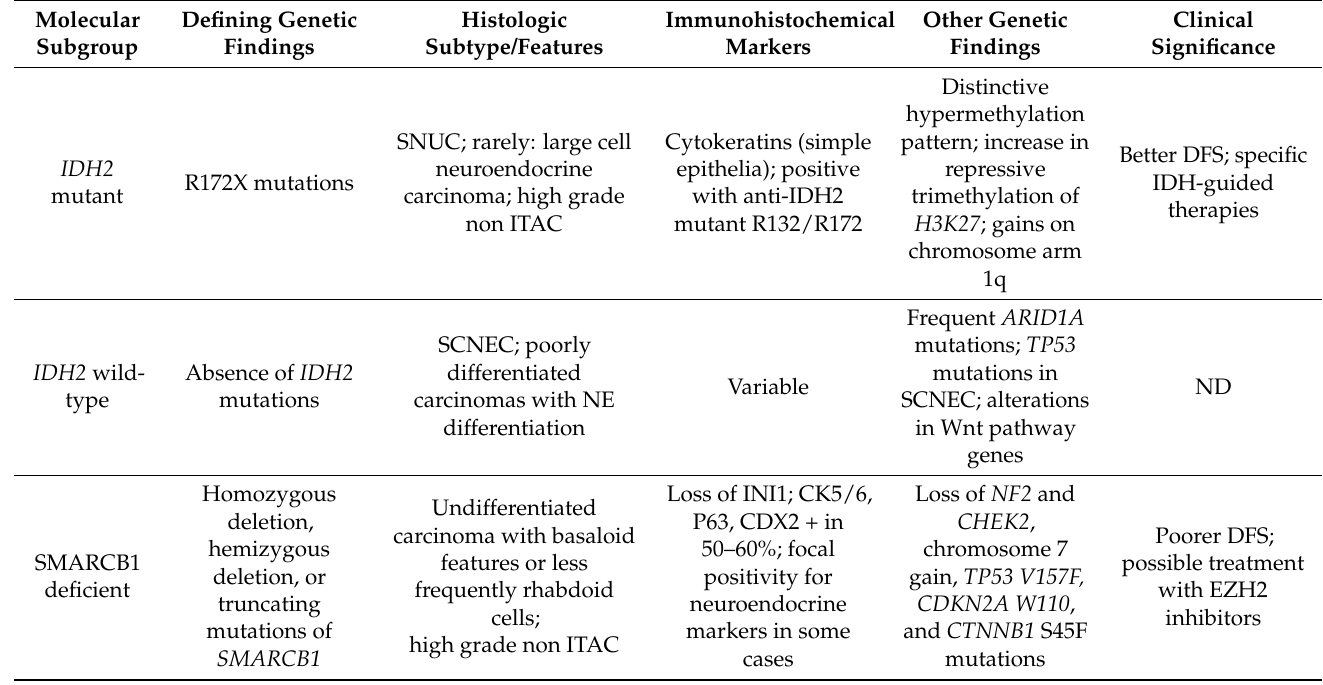
Table 2. Molecular subgroups of sinonasal undifferentiated